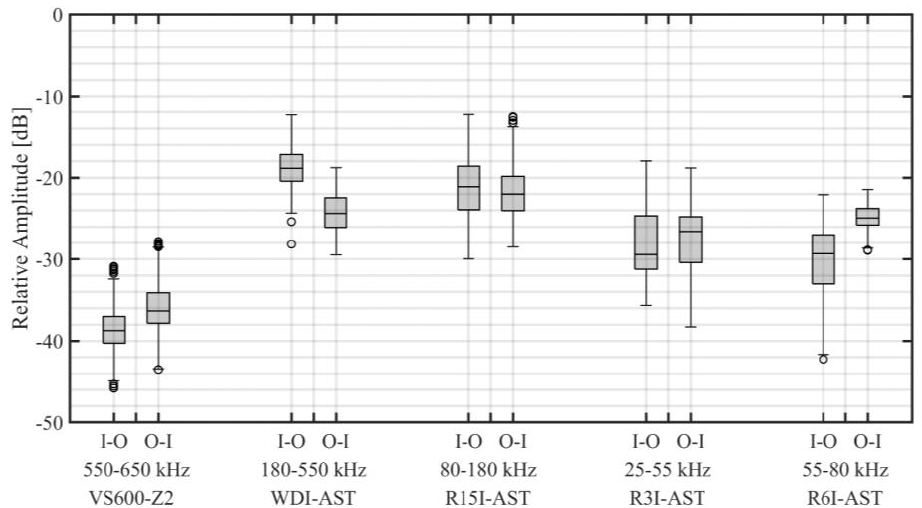
Figure 11. Overview of relative amplitude for different frequency ranges and transmission directions, where I-O refers to transmission from the inner ring to the outer ring, and O-I to transmission from the outer ring to the inner ring. The shaded box denotes the median and the range between the lower and the upper quartile, the circles represent outliers, and the whiskers indicate the non-outlier minima and